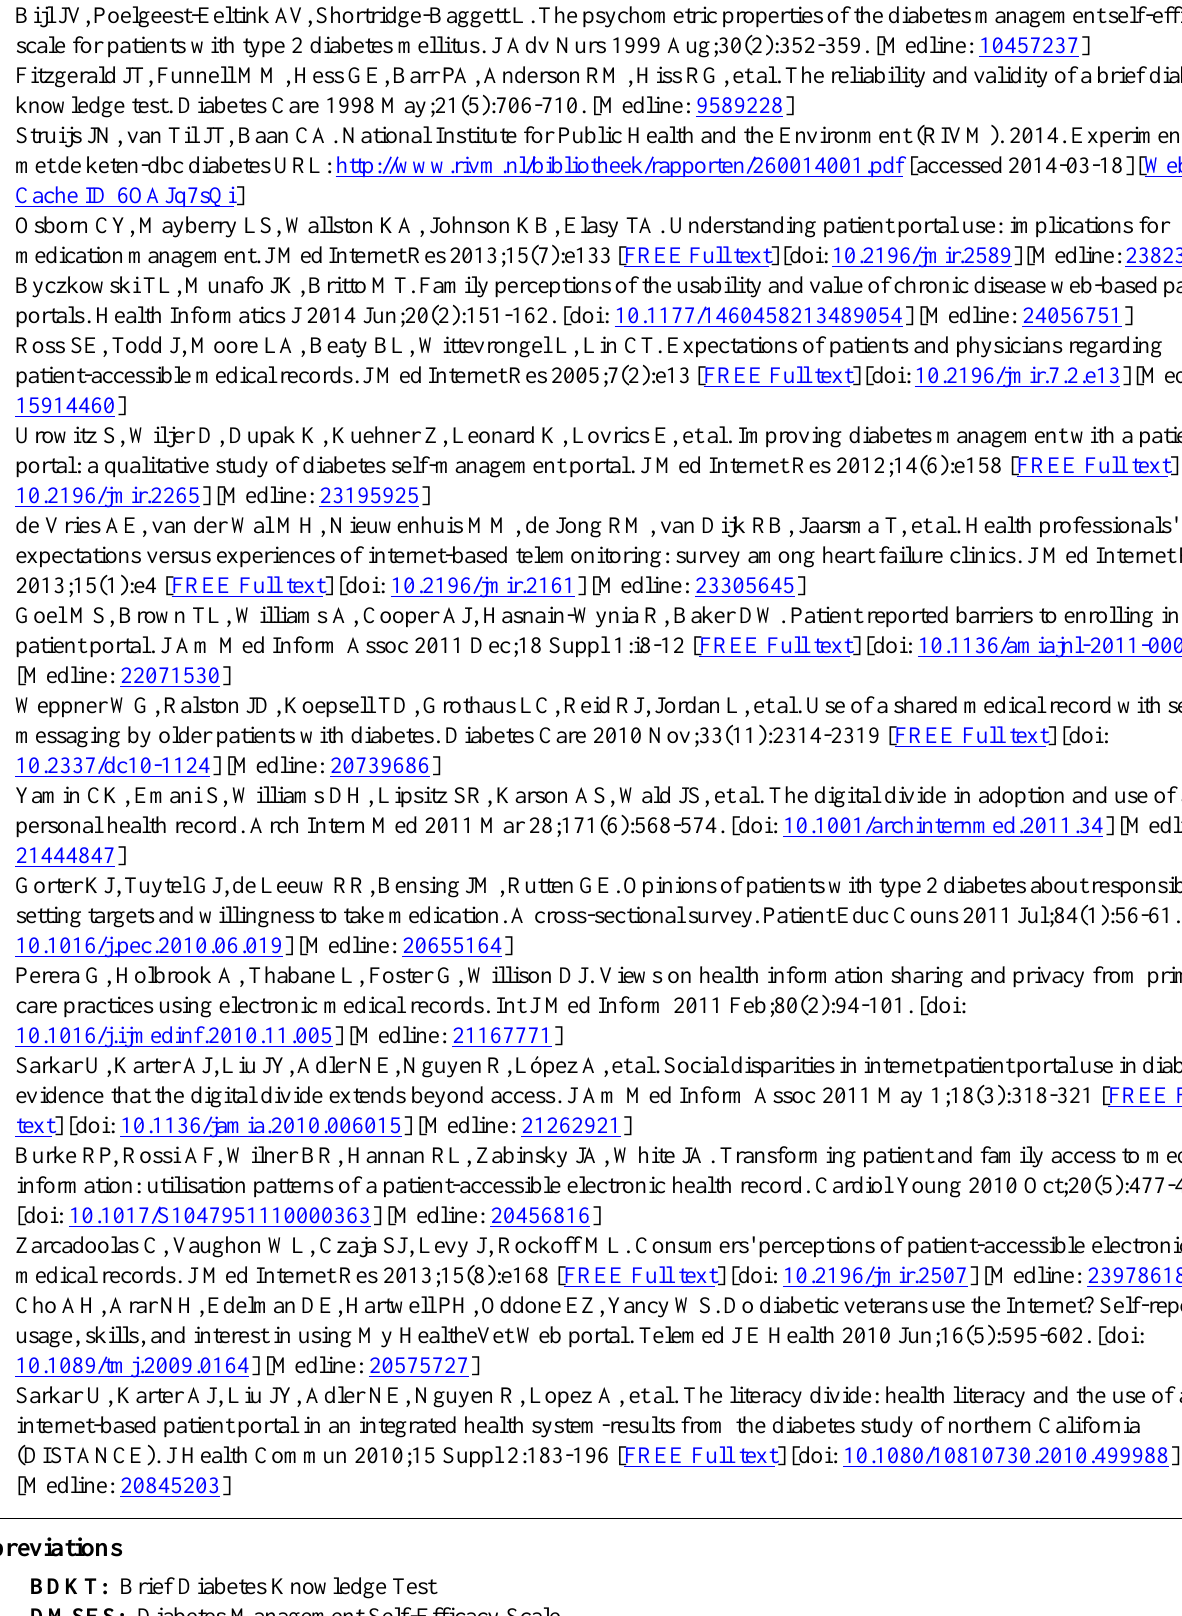
BDKT: Brief Diabetes Knowledge Test DMSES: Diabetes Management Self-Efficacy Scale DTSQ: Diabetes Treatment Satisfaction Questionnaire PAID: Problem Areas in